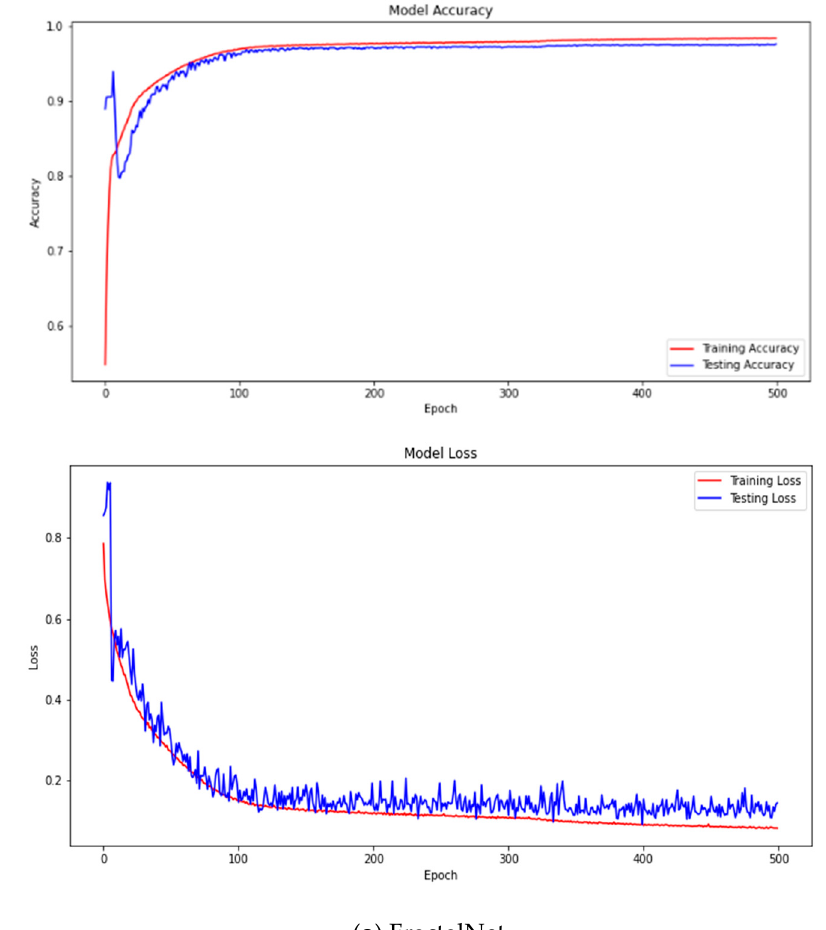
Figure 4. Plotting Model loss and Accuracy ( a ) SegNet; ( b ) ResNet; ( c ) U − Net; ( d ) U − Net2 ( e ) U − Net3 ( f ) V-Net, ( g ) FractalNet, Training(red) vs. testing (blue).